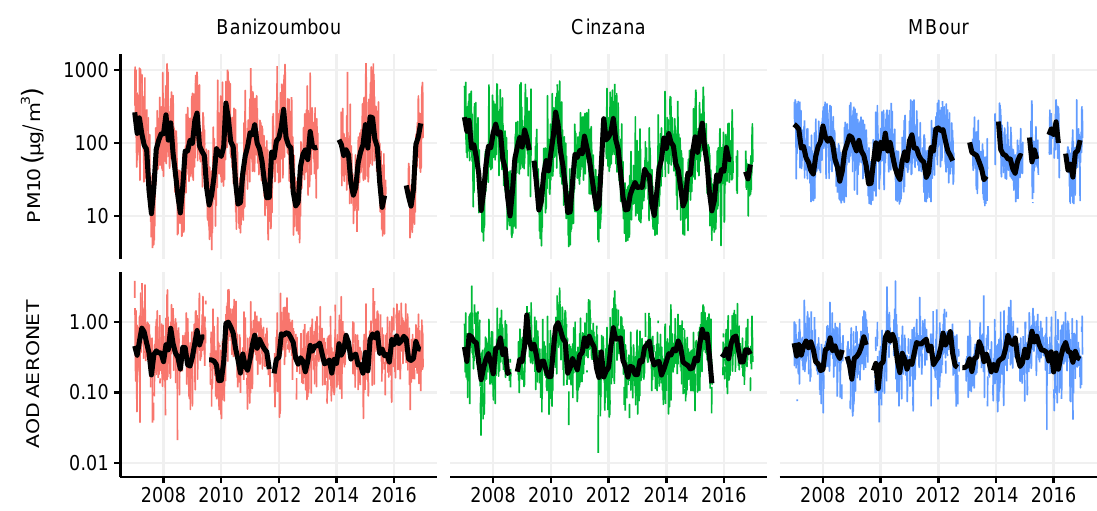
Figure 2. Daily PM10 ( top ) concentrations and AERONET AOD at 550 nm ( bottom ) observed at Banizoumbou, Cinzana and M’Bour between 2007 and 2017. Black solid line are the monthly